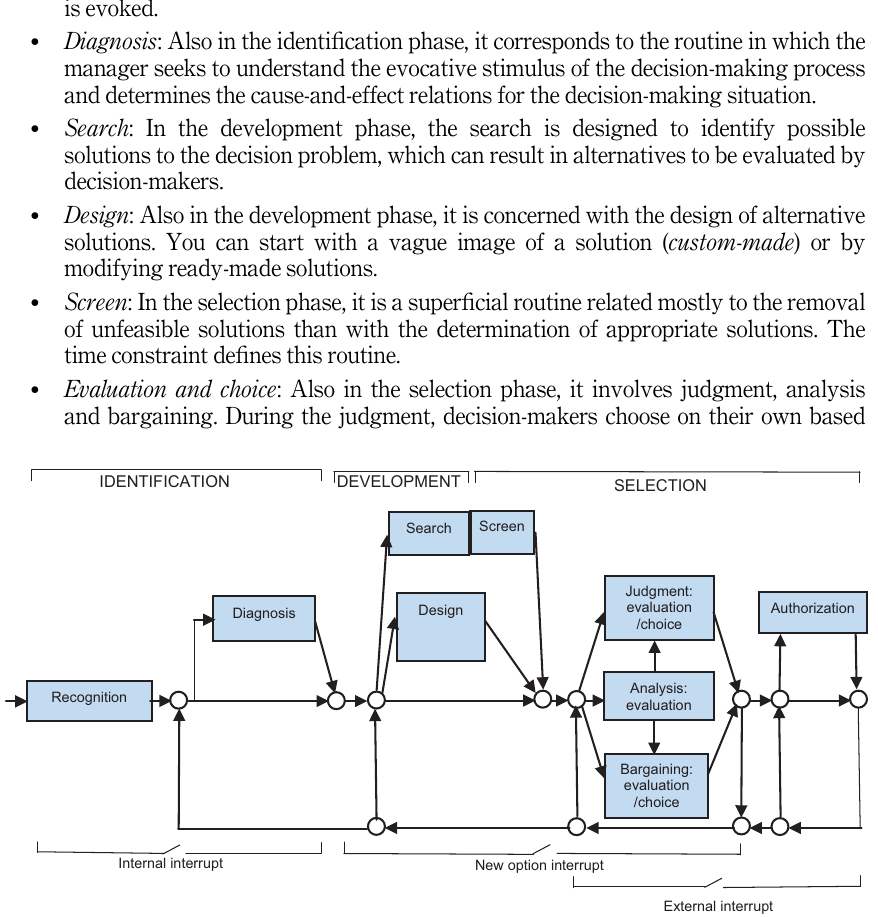
Figure 1. A general model of strategic